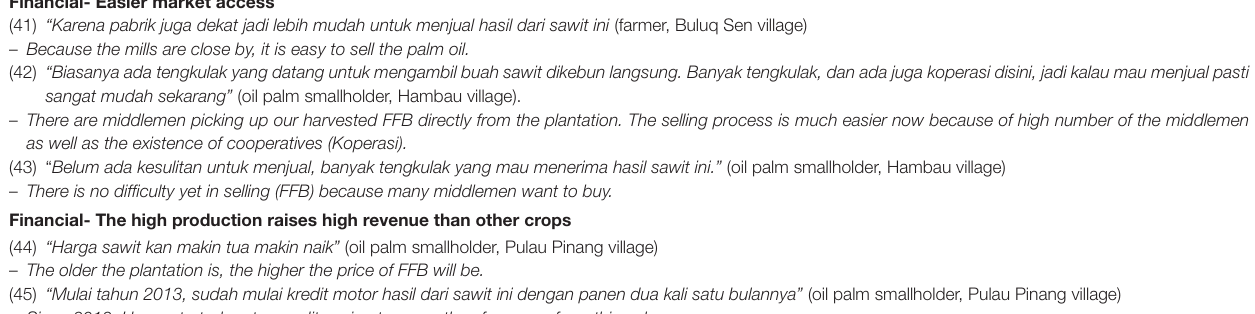
TABLE 7 | Reasons of local communities in Kutai Kartanegara to expand oil palm plantations. Financial- Easier market access (41) “Karena pabrik juga dekat jadi lebih mudah untuk menjual hasil dari sawit ini (farmer, Buluq Sen